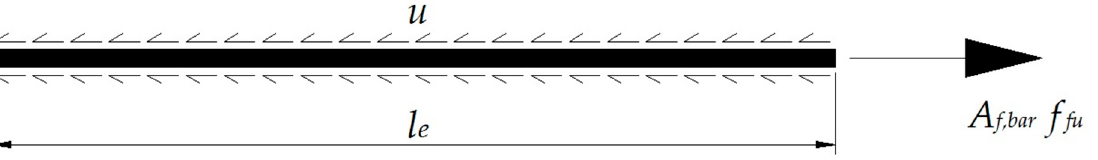
Figure 7. Transfer of force through bond.